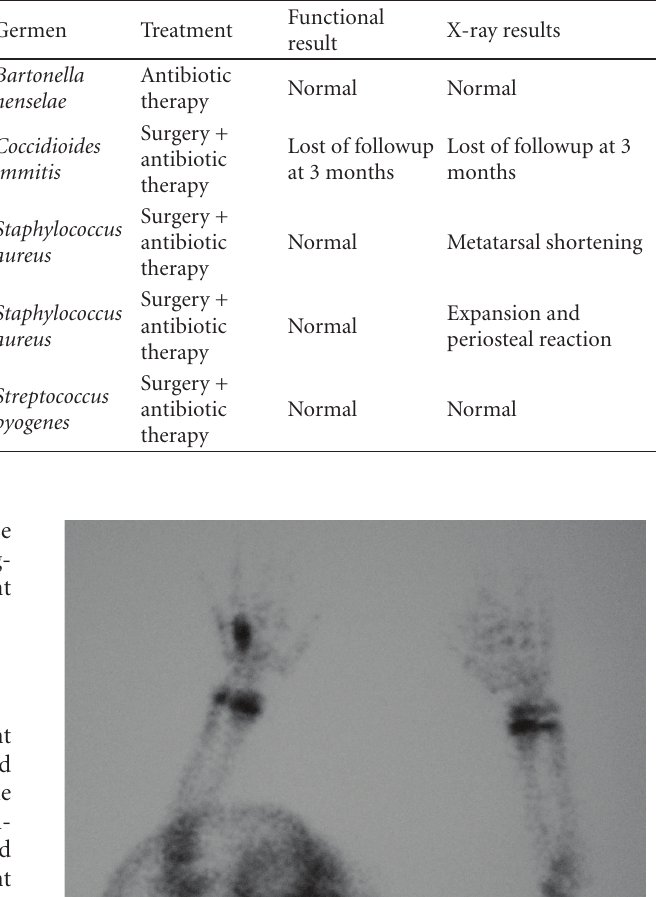
Figure 2: Scintigraphy showing 4th metacarpal and surrounding soft tissue